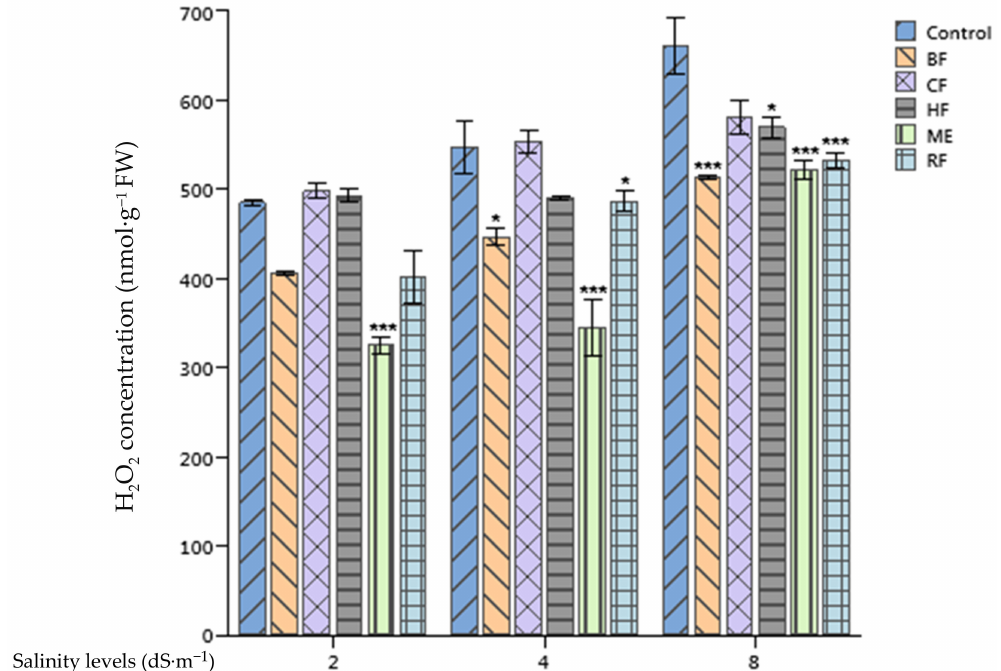
Figure 2. Effect of priming tomato seeds with Ulva lactuca methanol extract (ME), hexane fraction (HF), chloroform fraction (CF), n-butanol fraction (BF), and residual fraction (RF) under different salinity levels (2, 4, 8 dS · m − 1 ) on hydrogen peroxide concentration of tomato leaves. Mean ± SD values followed by asterisks indicate significant differences between treatments and the control (* p < 0.05; *** p <